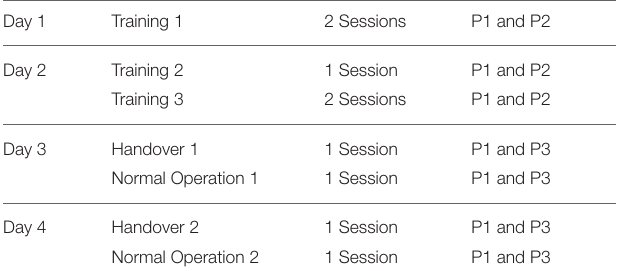
TABLE 1 | Timetables of the different sessions (both the Training and the Normal Operation) for P1, P2, and